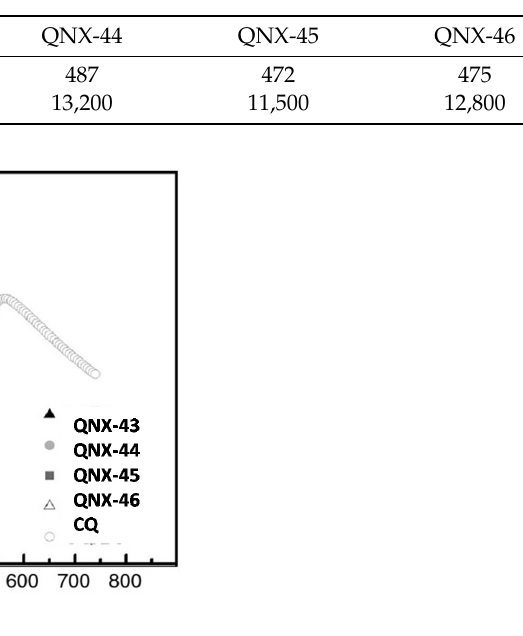
Figure 39. Polymerization profiles obtained during the FRP of TMPTA using the two-component dye/NPG photo-initiating systems upon irradiation with a Xe lamp. Reprinted from Ref. [247] Copyright 2014, Wiley Table 14. Optical characteristics of QNX-43-QNX-46 in 1-methylpyrrolidone.